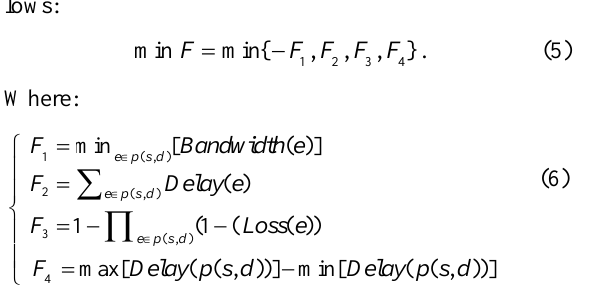
Fig.2. Dynamic topology of